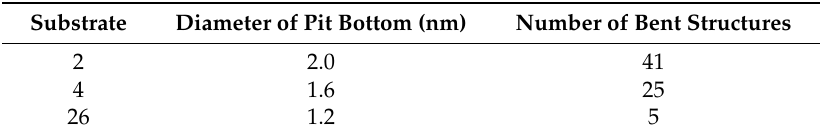
Table 1. Number of bent structures appearing in 100 rounds of heating and cooling cycles. Substrate Diameter of Pit Bottom (nm) Number of Bent Structures